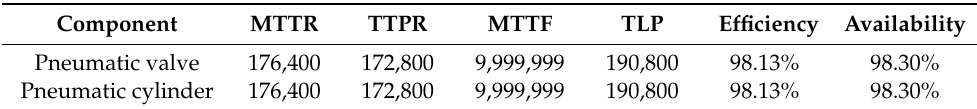
Table 9. Pneumatic components times in seconds. Efficiency and availability calculated in % with PPM strategy.